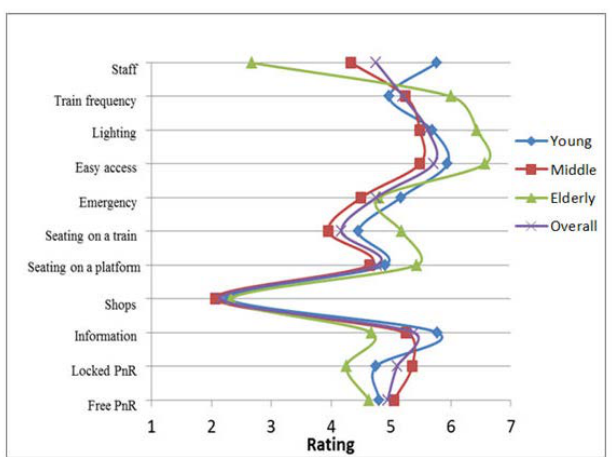
Figure 4. Service Quality of Greenwood Station